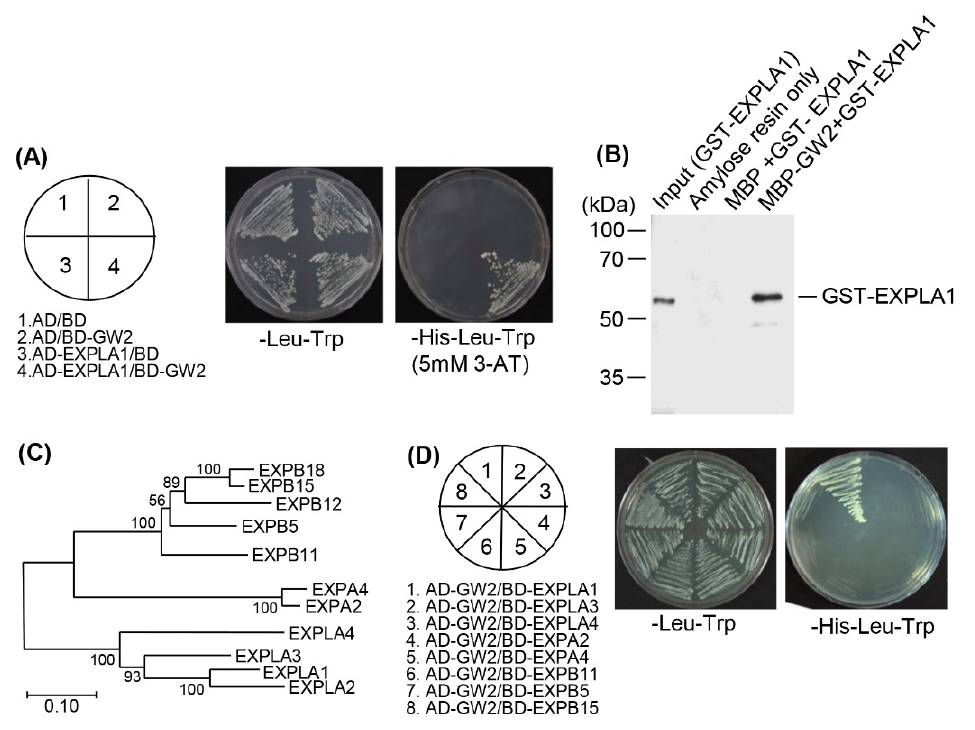
Table 1. List of GW2 ‐ interacting proteins that were isolated by yeast two ‐ hybrid screening. Colony